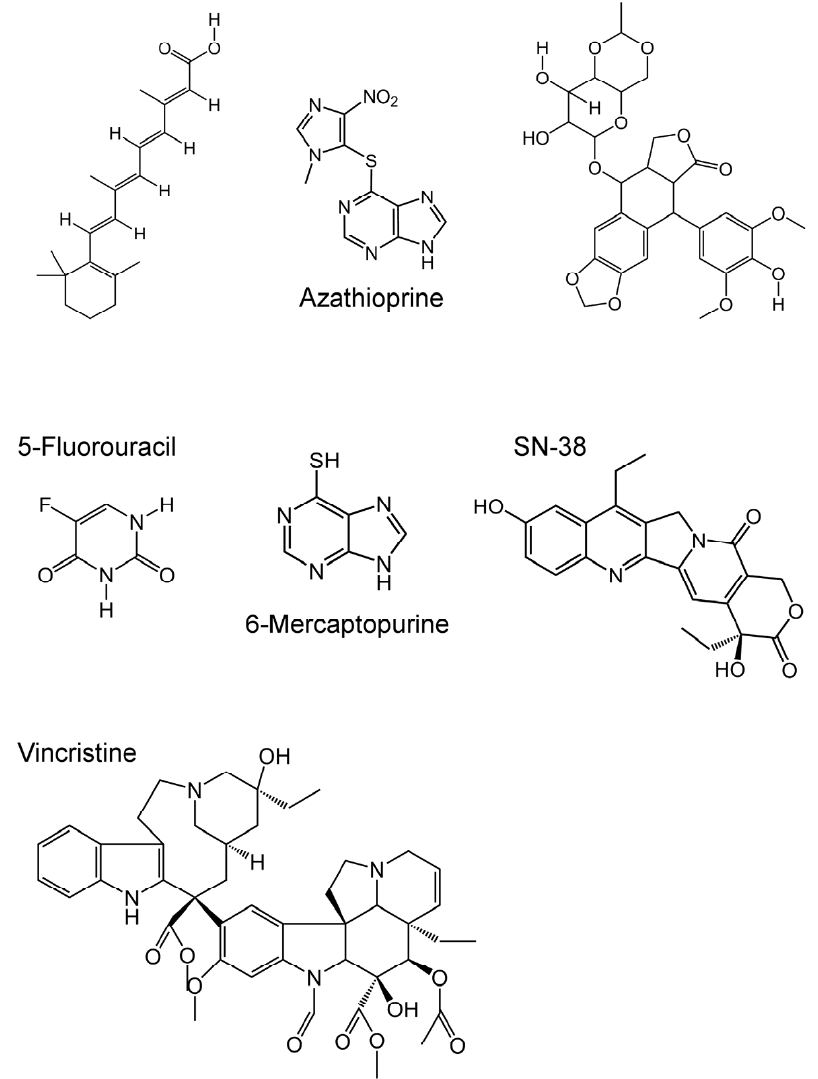
Figure 4. Structures of the anticancer drugs tested in the present study.